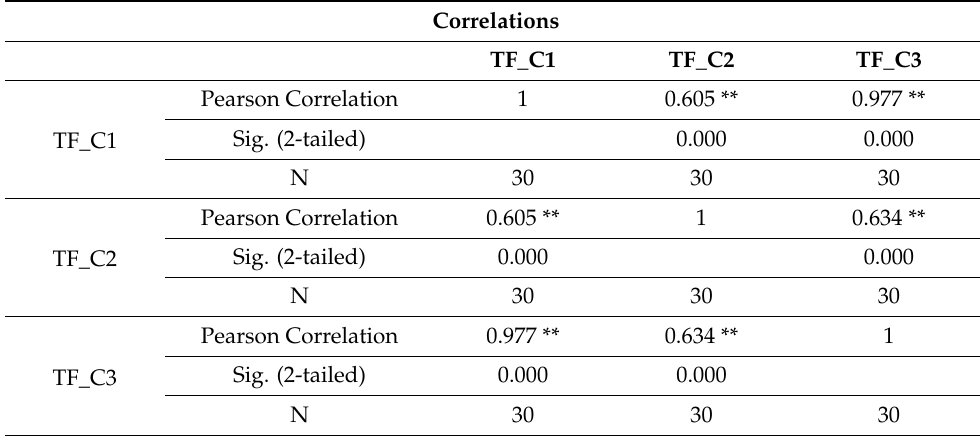
Table 11. Correlation test on traffic